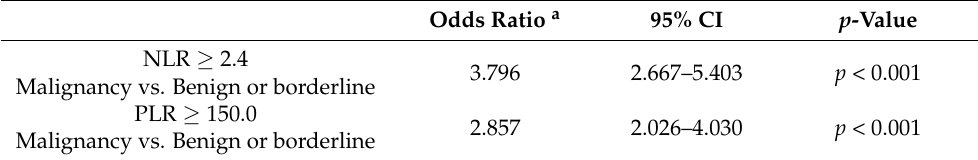
Table 4. Odds ratio of malignant ovarian tumors according to NLR and PLR. Odds Ratio a 95% CI p -Value NLR ≥ 2.4 Malignancy vs. Benign or borderline